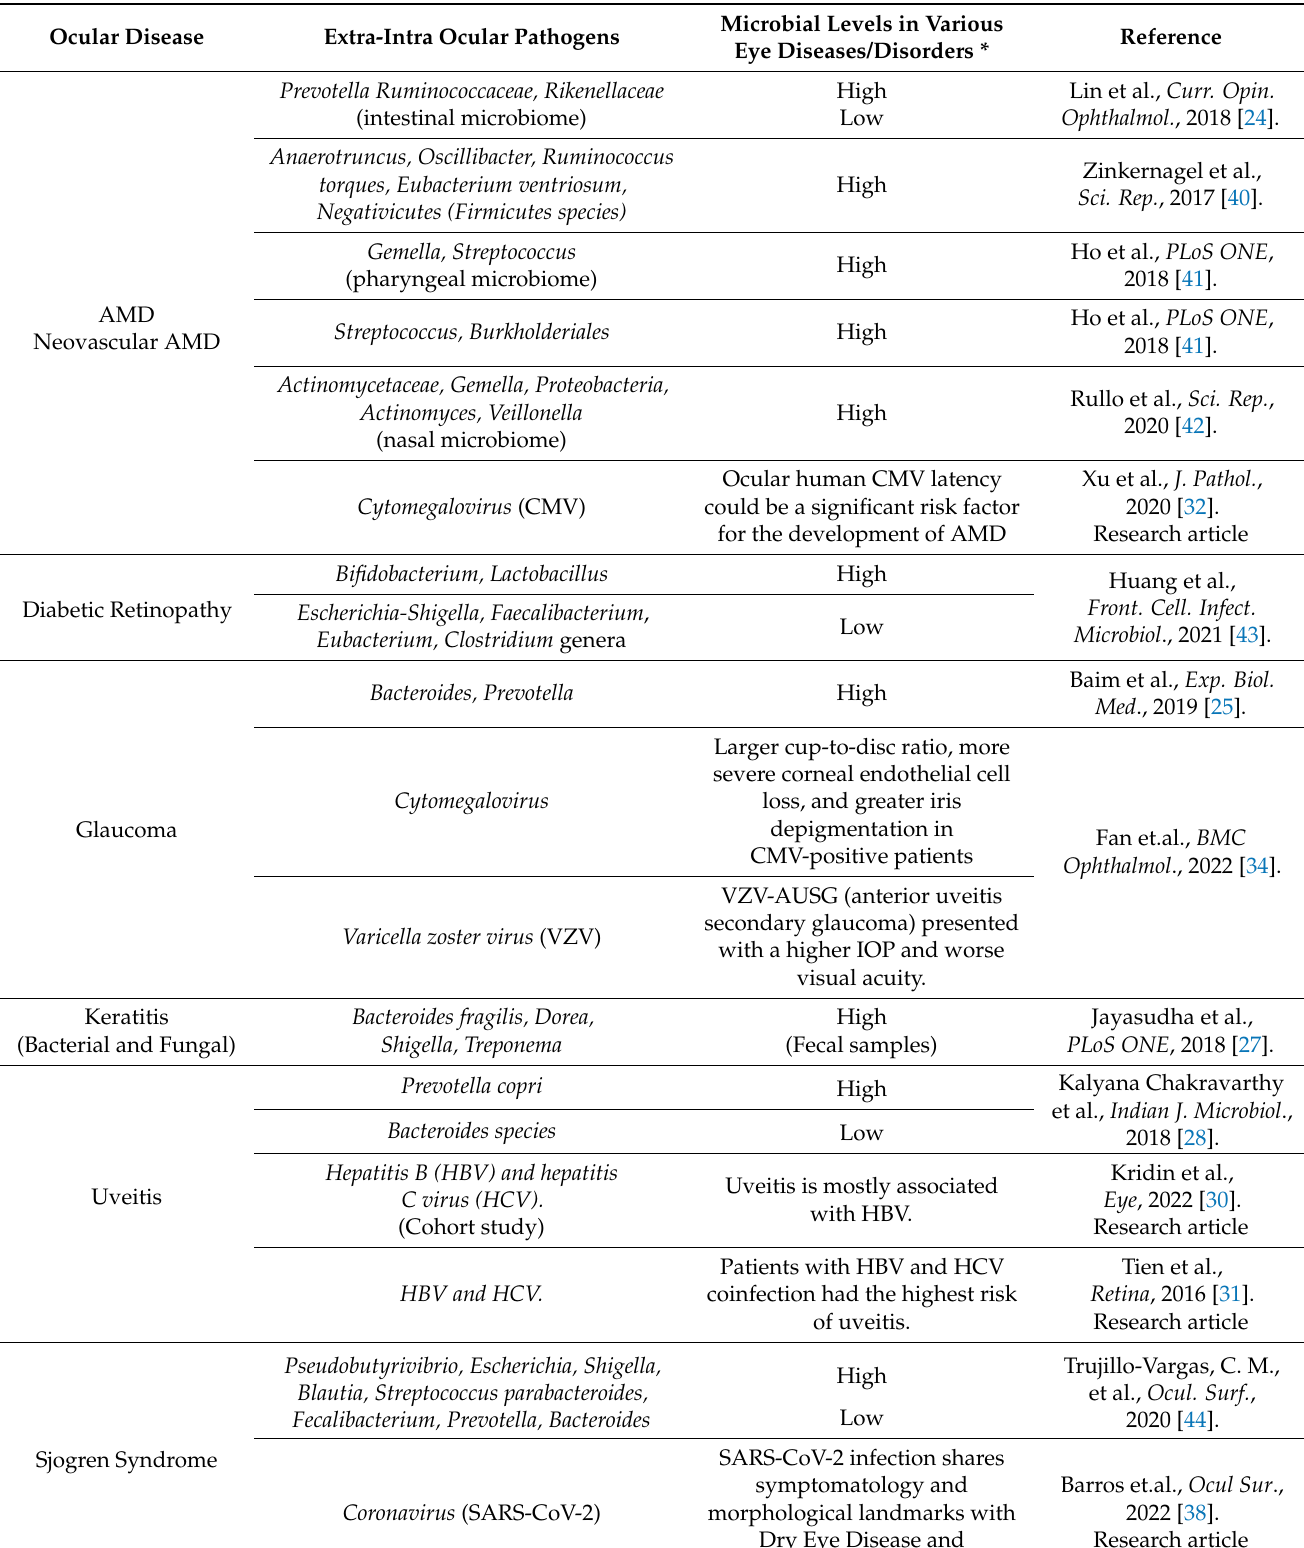
Table 1. Extra and Intra Ocular Pathogens and